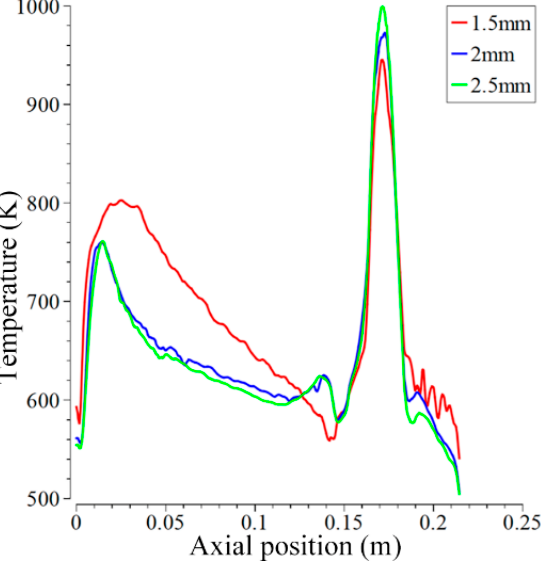
Figure 19. Wall temperature curves under different rib width conditions. The wall surface in the middle and outlet of the converging section of the nozzle also followed the same temperature distribution pattern as the wall surface of the cylinder section. The larger the rib width, the lower the overall inner wall temperature. In the throat region, however, the wall temperature distribution law changed. The overall wall temperature in the region increased as the rib width increased. The difference was approximately 20